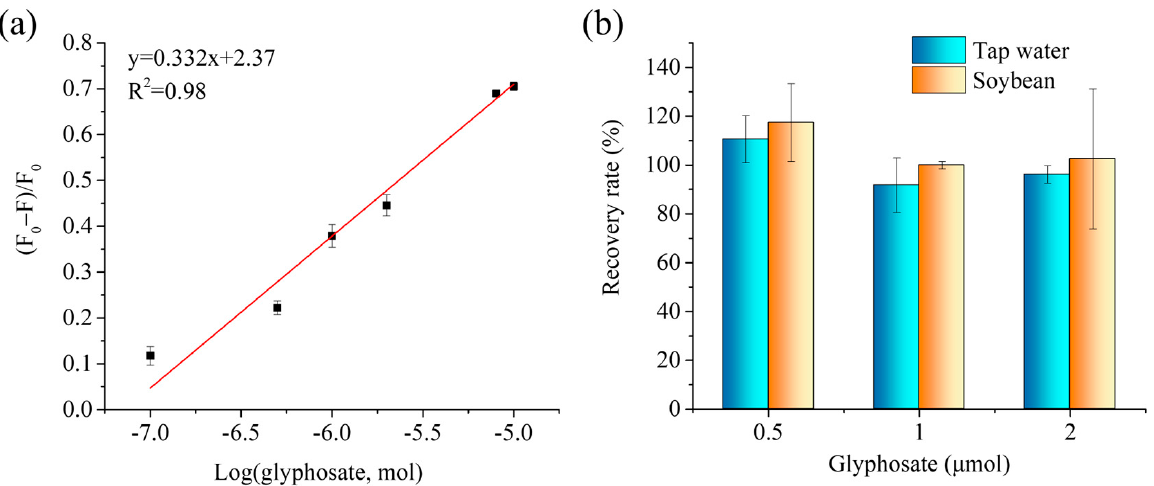
Figure 6. ( a ) Linear curve created by plotting fluorescence response of MIP@P towards glyphosate to its molar amount. ( b ) Spiked recovery rates of the developed fluorescent MIP@P sensor for the detection of the spiked glyphosate in tap water and soybean samples.